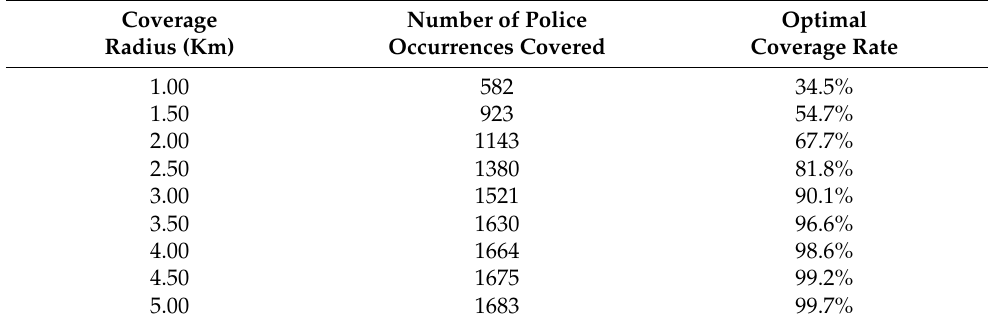
Table 2. Optimal coverage.